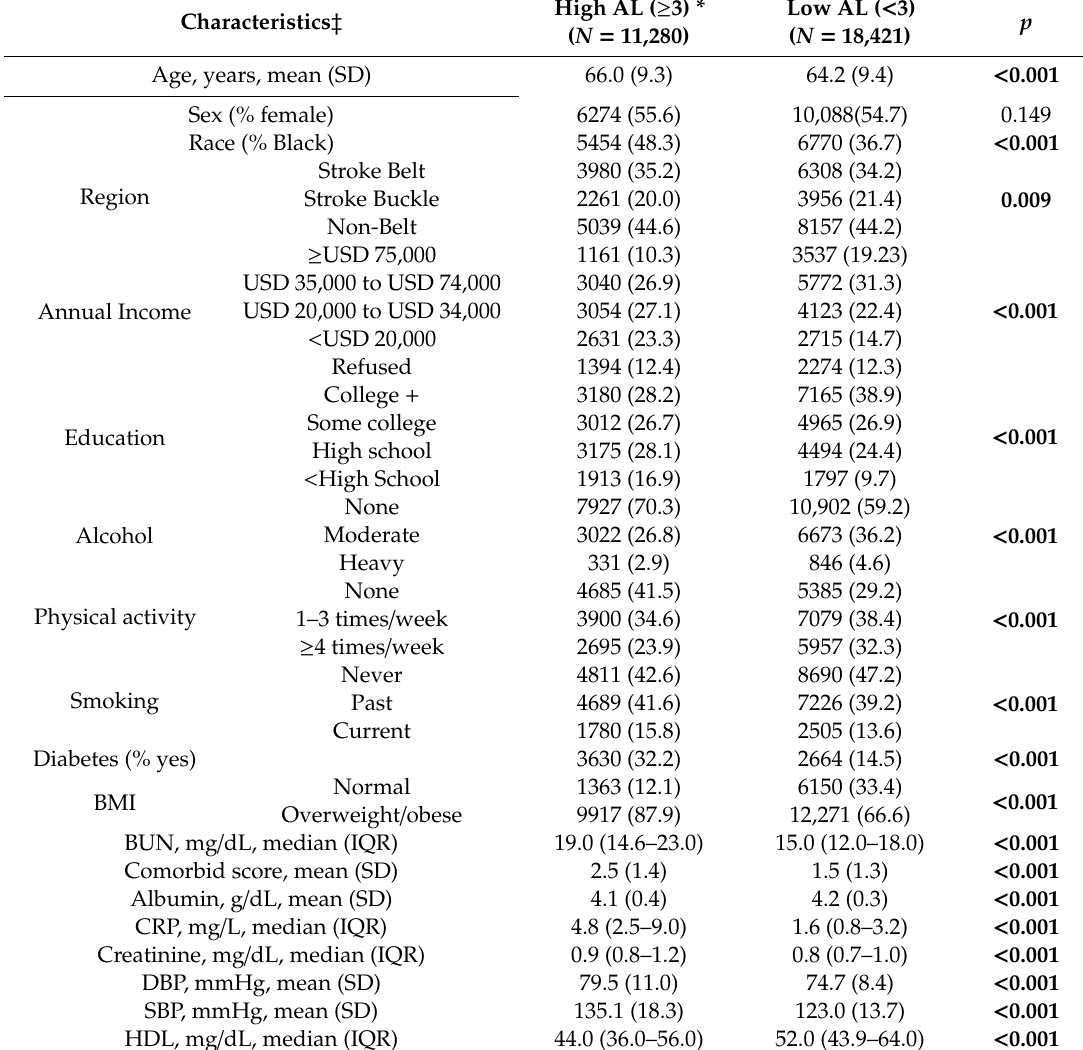
Table 2. Study Characteristics ‡ by Allostatic Load Categories * in the REGARDS cohort ( N = 29,701). Characteristics